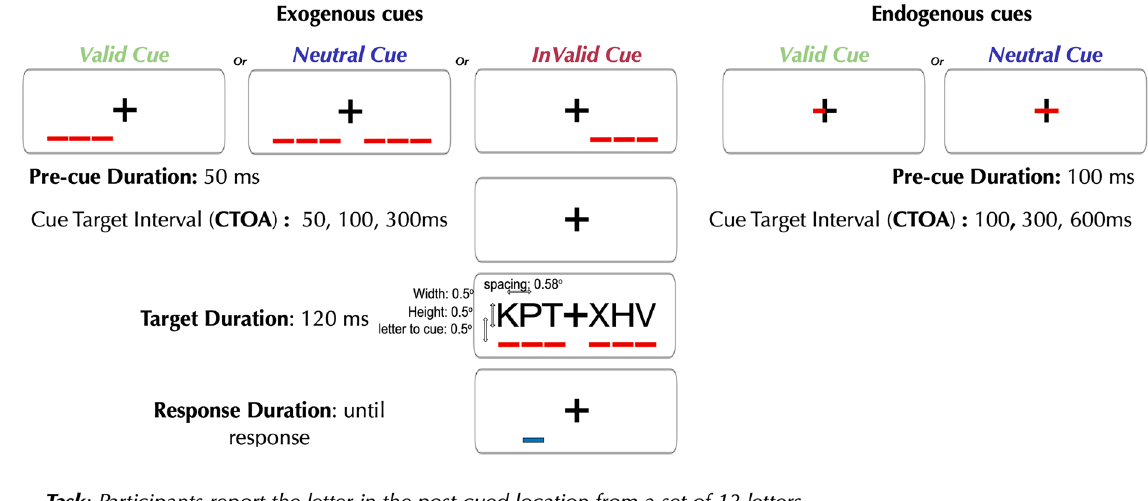
Figure 1. Example trial sequence for the exogenous and endogenous attention experiments in the letter recognition